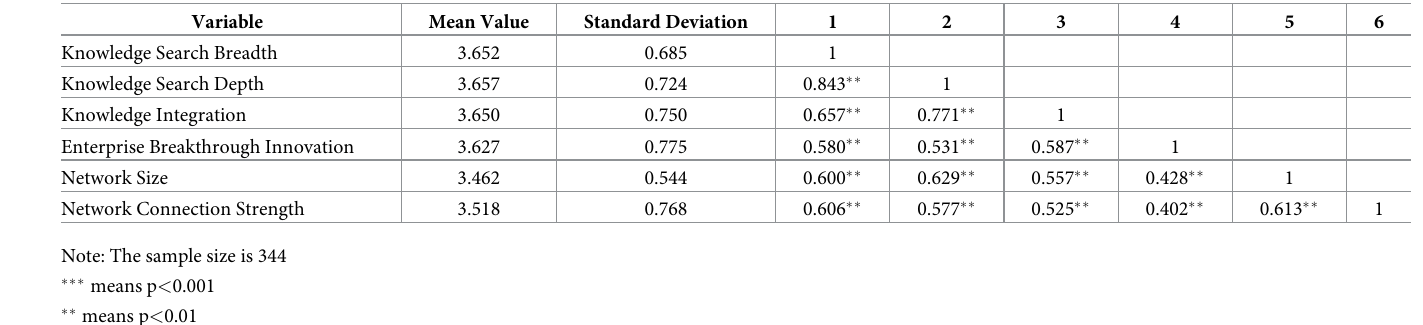
Table 5. Descriptive statistical analysis of